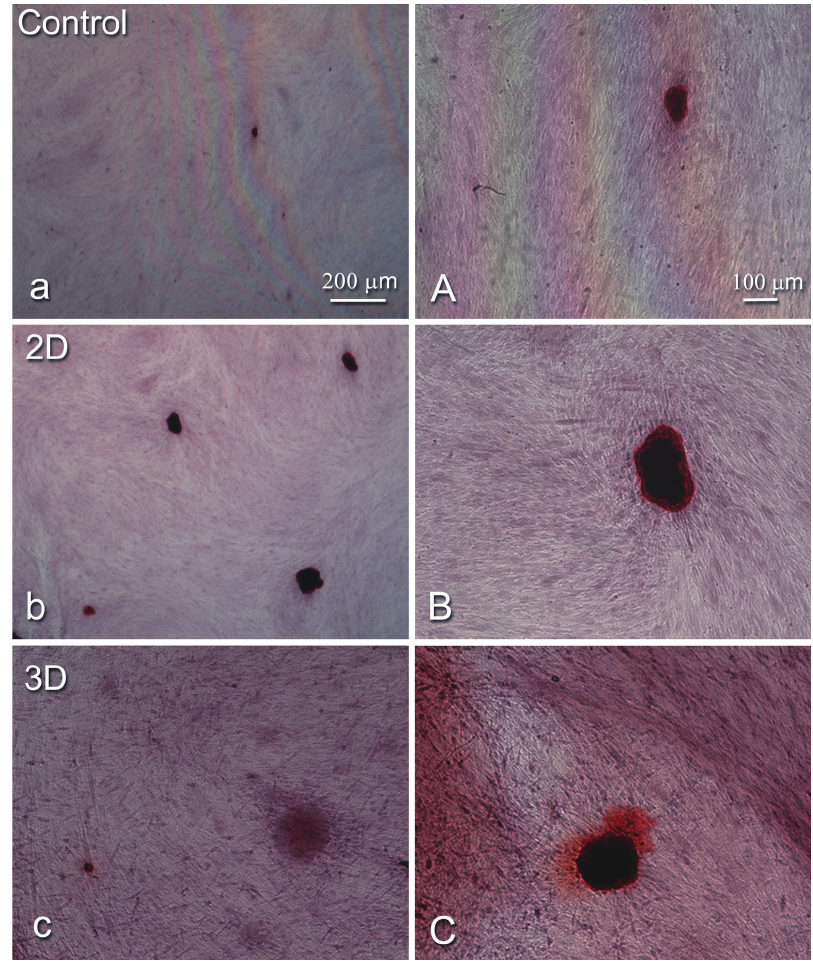
Figure 6- Alizarin red staining of mineralized nodule formation in hPDLF cultures. Control (a and A), 2D collagen (b and B), and 3D collagen (c and C). Bar a-c: 200 µm and Bar A-C: 100